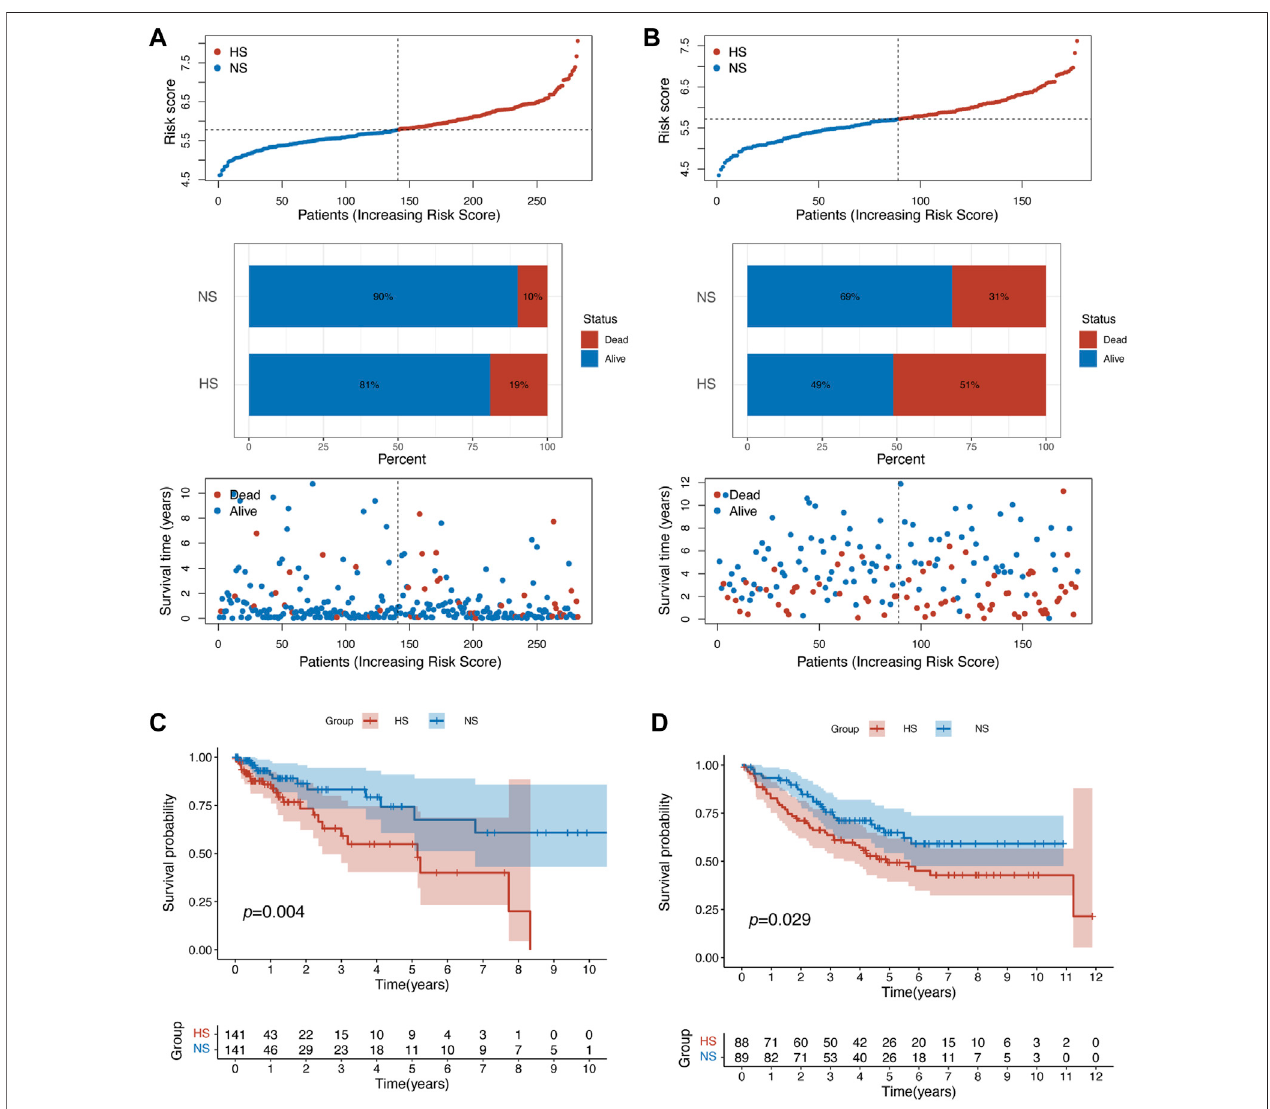
FIGURE3| Patientsindifferentsubgroupsshowedstatisticallydifferentprognoses. (A) Thepatientdistribution,riskscore,andstatusplotsshowedthatpatientsin theHSintrainingsetrelatedtopoorerprognosis. (B) Similarresultswereidenti fi edinthevalidationset.ThesurvivalplotofK-Manalysiscon fi rmedthatpatientsinHShad statistically poorer overall survival in the training (C) and validation (D)